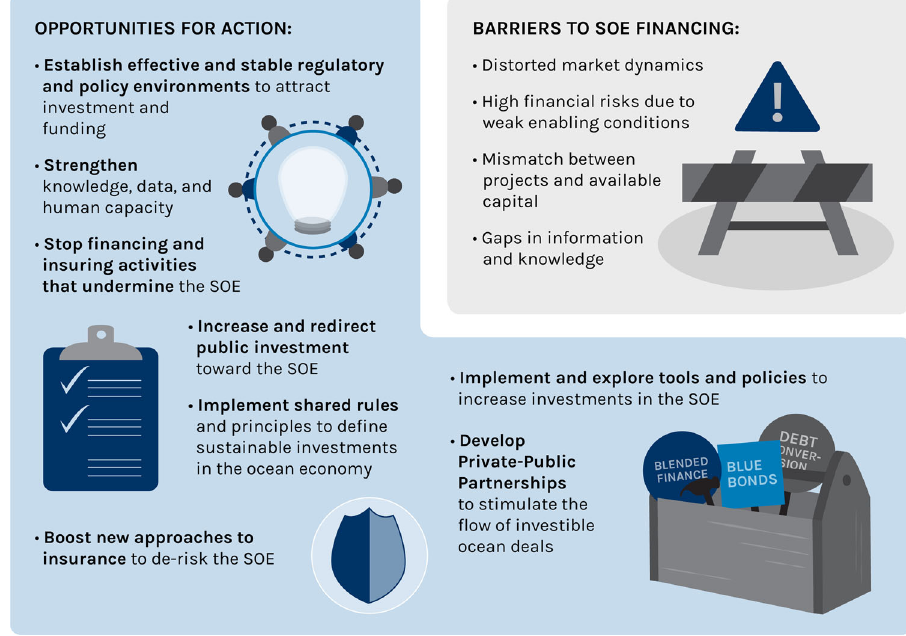
Fig. 5 Actions that create barriers to, and opportunities for, a sustainable ocean economy. Key barriers to the fl ow of fi nance to the ocean economy and opportunities for action to remove